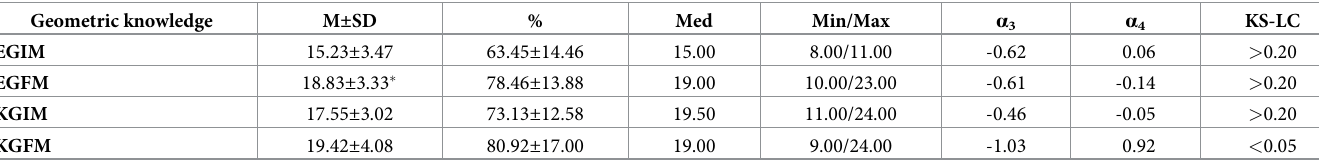
Table 1. Indicators of descriptive statistics for the experimental and control groups of